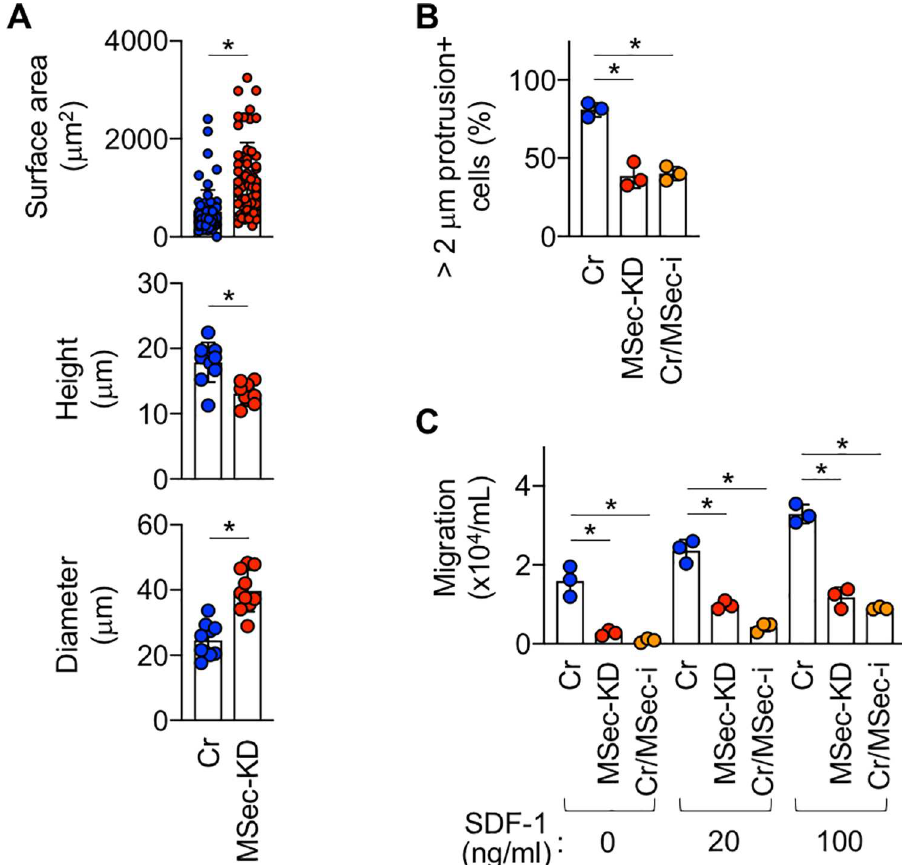
Fig 7. Effect of M-Sec knockdown/inhibition on morphology, membrane protrusions, and migration of MT-2 cells. ( A ) The control (Cr)- or M-Sec knockdown (MSec-KD) MT-2 cells were stained with phalloidin (to visualize F- actin) and analyzed for the surface area (top, 60 cells for each), height (middle, 10 cells for each), or diameter (bottom, 10 cells for each). � p < 0.05. ( B ) The control (Cr)- or M-Sec knockdown (MSec-KD) MT-2 cells were stained with phalloidin (to visualize F-actin) analyzed for membrane protrusions. Control cells pre-treated with M-Sec inhibitor for 48 h were also added (Cr/MSec-i). Three different fields were randomly selected, and the percentages of membrane protrusions + cells were quantified. � p < 0.05. ( C ) The control (Cr)- or M-Sec knockdown (MSec-KD) MT-2 cells were analyzed for migratory activity by using transwell assay. Control cells pre-treated with M-Sec inhibitor (MSec-i) for 48 h were also added. The migration toward SDF-1 (20 or 100 ng/mL) was also assessed. The numbers of cells that migrated through the inserts into lower wells were enumerated by the trypan blue dye exclusion method (n = 3). � p <